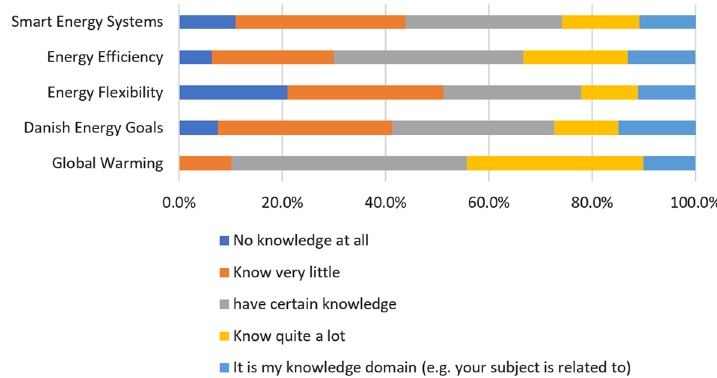
Fig. 3 The percentage of surveyed occupants’ knowledge in the energy domain